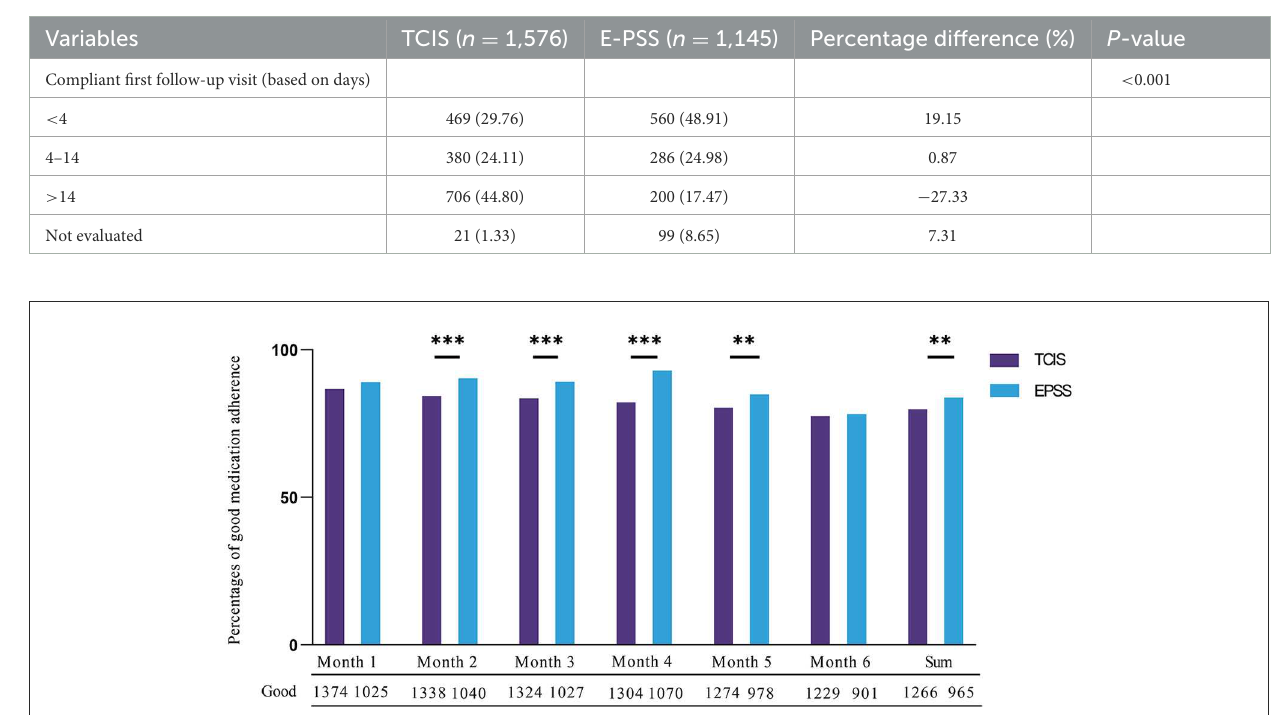
TABLE 2 Status of community visit in TCIS and e-PSS during 2020–2021 in Wuhan, China.